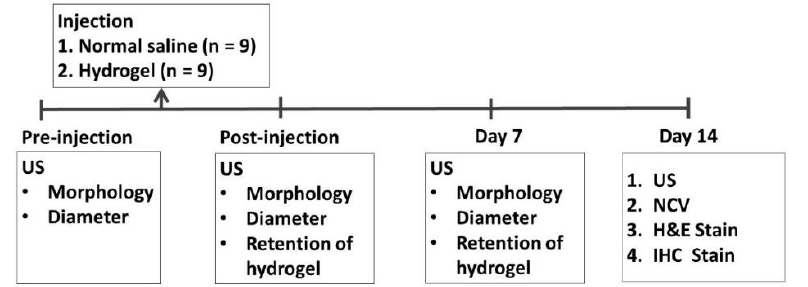
Figure 6. Schematic summary of the experimental procedure and outcome measures (US, ultrasound imaging; NCV, nerve conduction velocities; H&E, hematoxylin amd eosin; IHC, immunohistochemical).